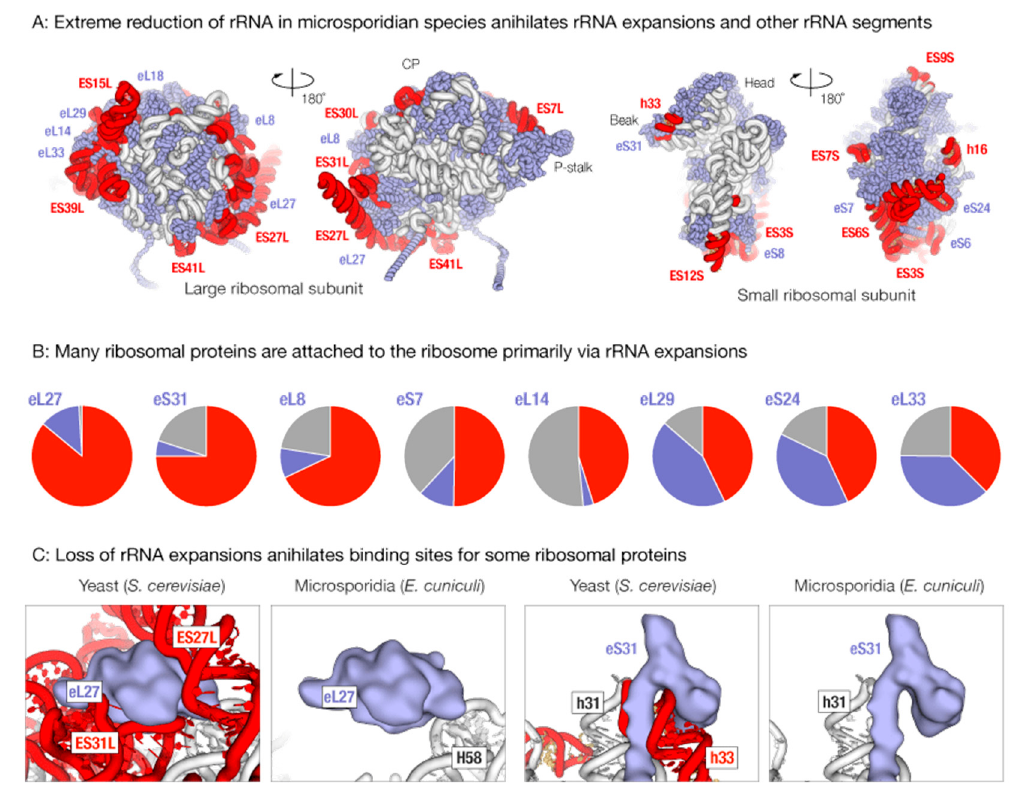
Figure 1. Extreme reduction of microsporidian rRNA appears to annihilate many rRNA-protein contacts, transforming some ribosomal proteins into ribosome-bound or free-standing rudiments with no apparent biological function. ( A ) The panel illustrates massive loss of rRNA expansion segments in microsporidian ribosomes. It shows the ribosome structure from yeast Saccharomyces cerevisiae —a non-parasitic fungi that is one of the closest non-parasitic relatives of Microsporidia for which there is a known ribosome structure – in which the rRNA segments that are missing in microsporidian species are highlighted in red. The rRNA segments that are conserved between the yeasts and Microsporidia are shown in grey, and ribosomal proteins are shown in blue. ( B ) The diagrams summarize the rRNA-protein and protein-protein interface for eight ribosomal proteins that form interact primarily with rRNA expansion segments in the 80S yeast ribosome. ( C ) The panels zoom on the structure of the 80S ribosomes to illustrate that protein eS31 is anchored to the ribosome via its contact with helix h16 in the 16S rRNA, and protein eL27 is sandwiched between the rRNA expansion segments ES27L and ES31L in the 25S rRNA. Because h16, ES27L, and ES31L are fully degenerated in microsporidian rRNA, microsporidian proteins eL27 and eS31 are predicted to no longer be components of protein synthesis machinery and rather be free-standing proteins in Microsporidia .